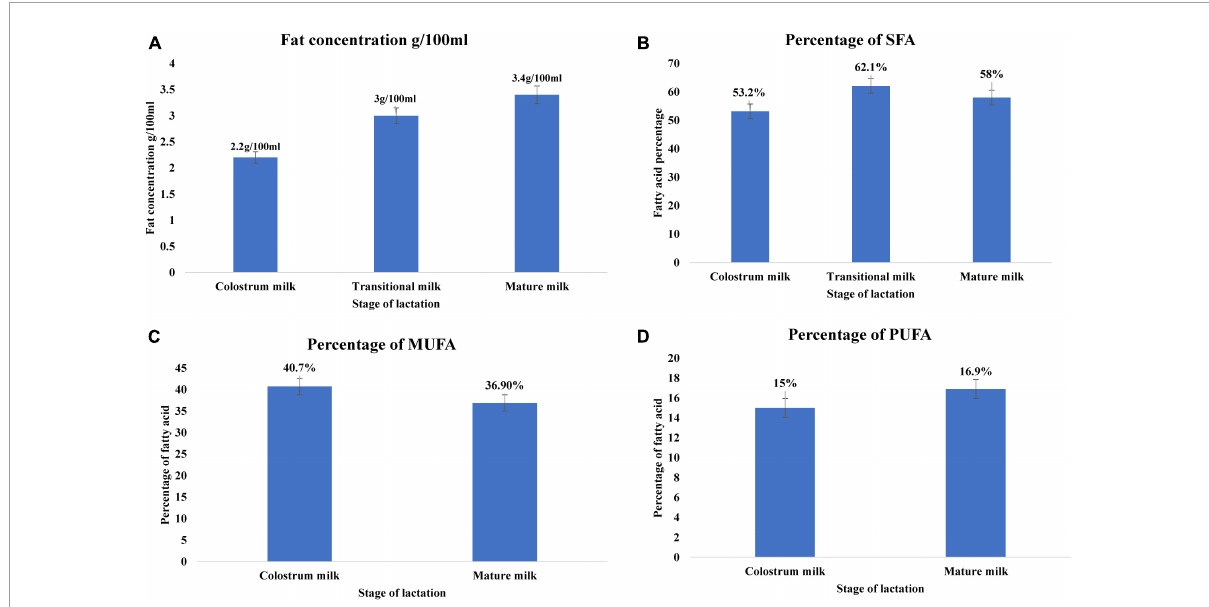
FIGURE2 Lipid profile of breast milk across lactation stage (21). (A) Fat concentration (g/100 mL) of breast milk across the lactation stage. (B) Percentage of saturated fatty acid of breast milk across lactation stage. (C) Percentage of monounsaturated fatty acid of breast milk across lactation stage. (D) Percentage of polyunsaturated fatty acid of breast milk across lactation stage. Lactation stage—colostrum milk 0–5 days of postnatal life, transitional milk—6–15 days of postnatal life, and mature milk—16–60 days of postnatal life.